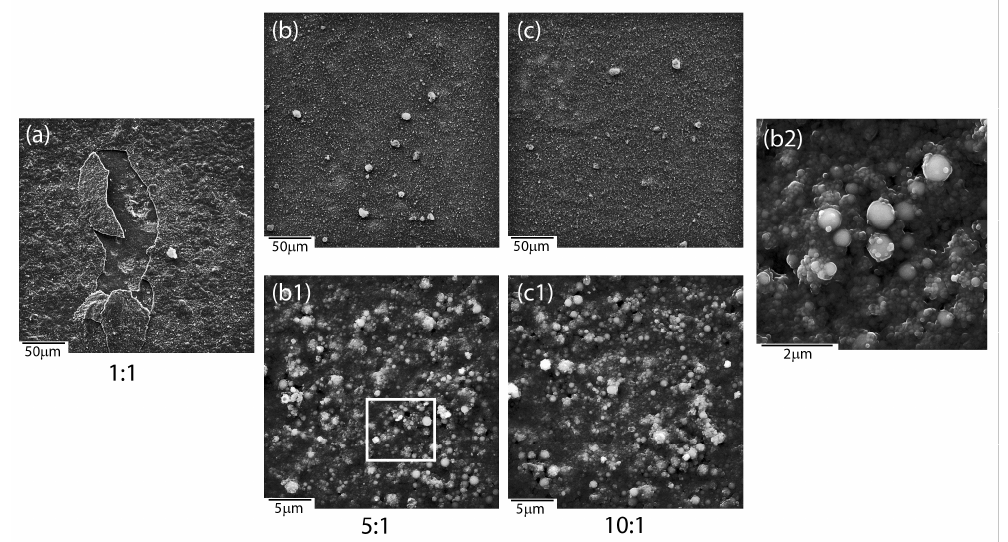
Figure 5. SEM images of coatings with different HAp:nSiO 2 /Ag after heat treatment: 1:1 ( a ), 5:1 ( b , b 1, b 2) and 10:1 ( c , c 1).